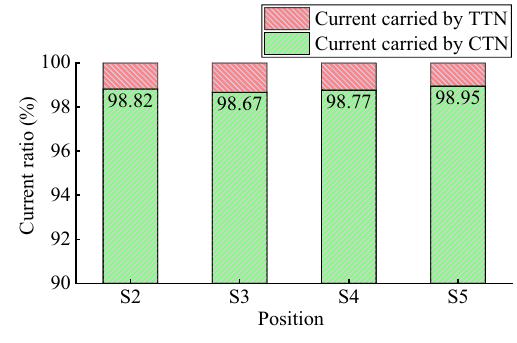
Fig. 11 Relationship of long-section current distribution